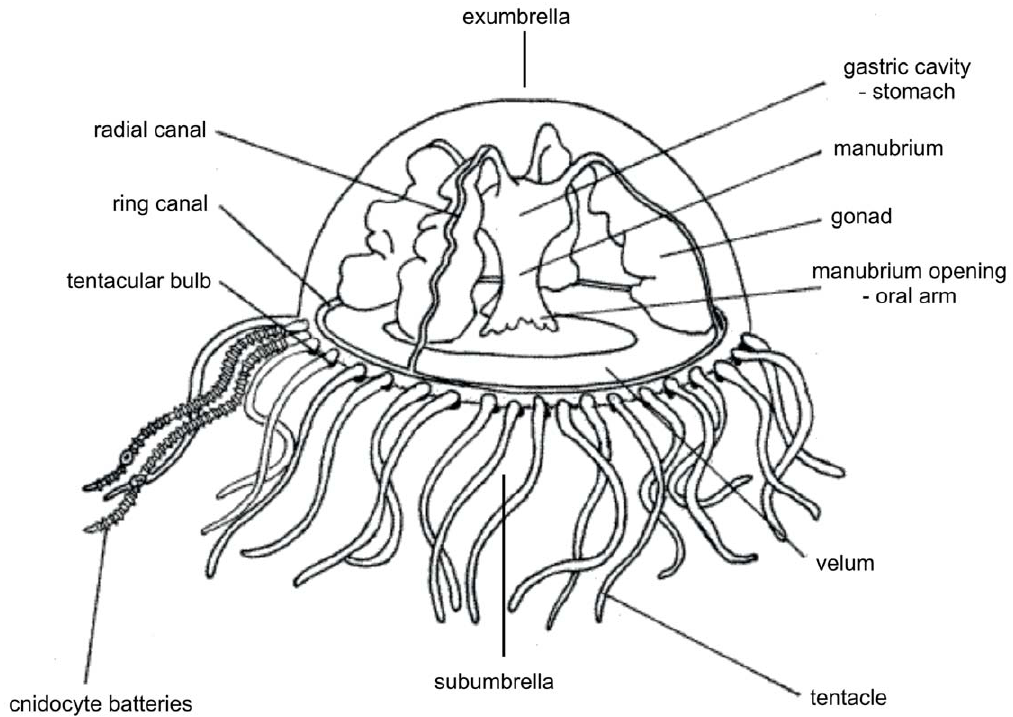
Figure 1. Craspedacustasowerbyi body plan scheme. Radial symmetric body plan of Craspedacusta sowerbyi is divided in subumbrella and exumbrella regions from the side projection. The most distinct features are four gonads and the presence of up to two hundreds of tentacles. Particular organs are described in the scheme. Body size is up to 2.5 cm in diameter.